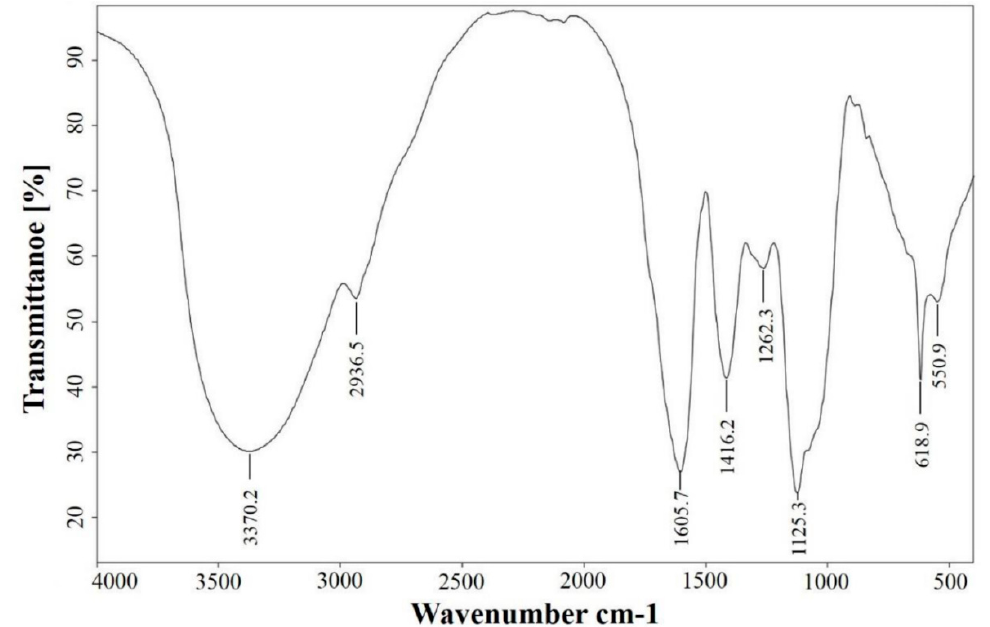
Figure 1. Infrared spectral analysis of Artemisia rupestris L. (AEAR).